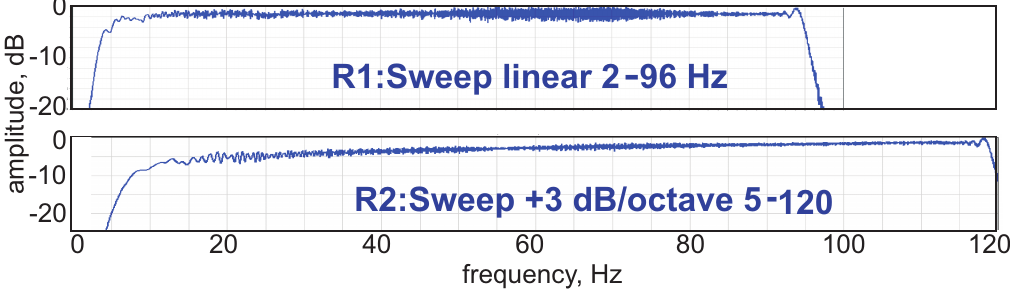
Figure 1. Observed frequency content of the vibrator sweeps (weighted sum ground force) as recorded on the baseplates during source quality control: ( Top ) regional (R1) mode, ( Bottom ) high-resolution (R2) mode.